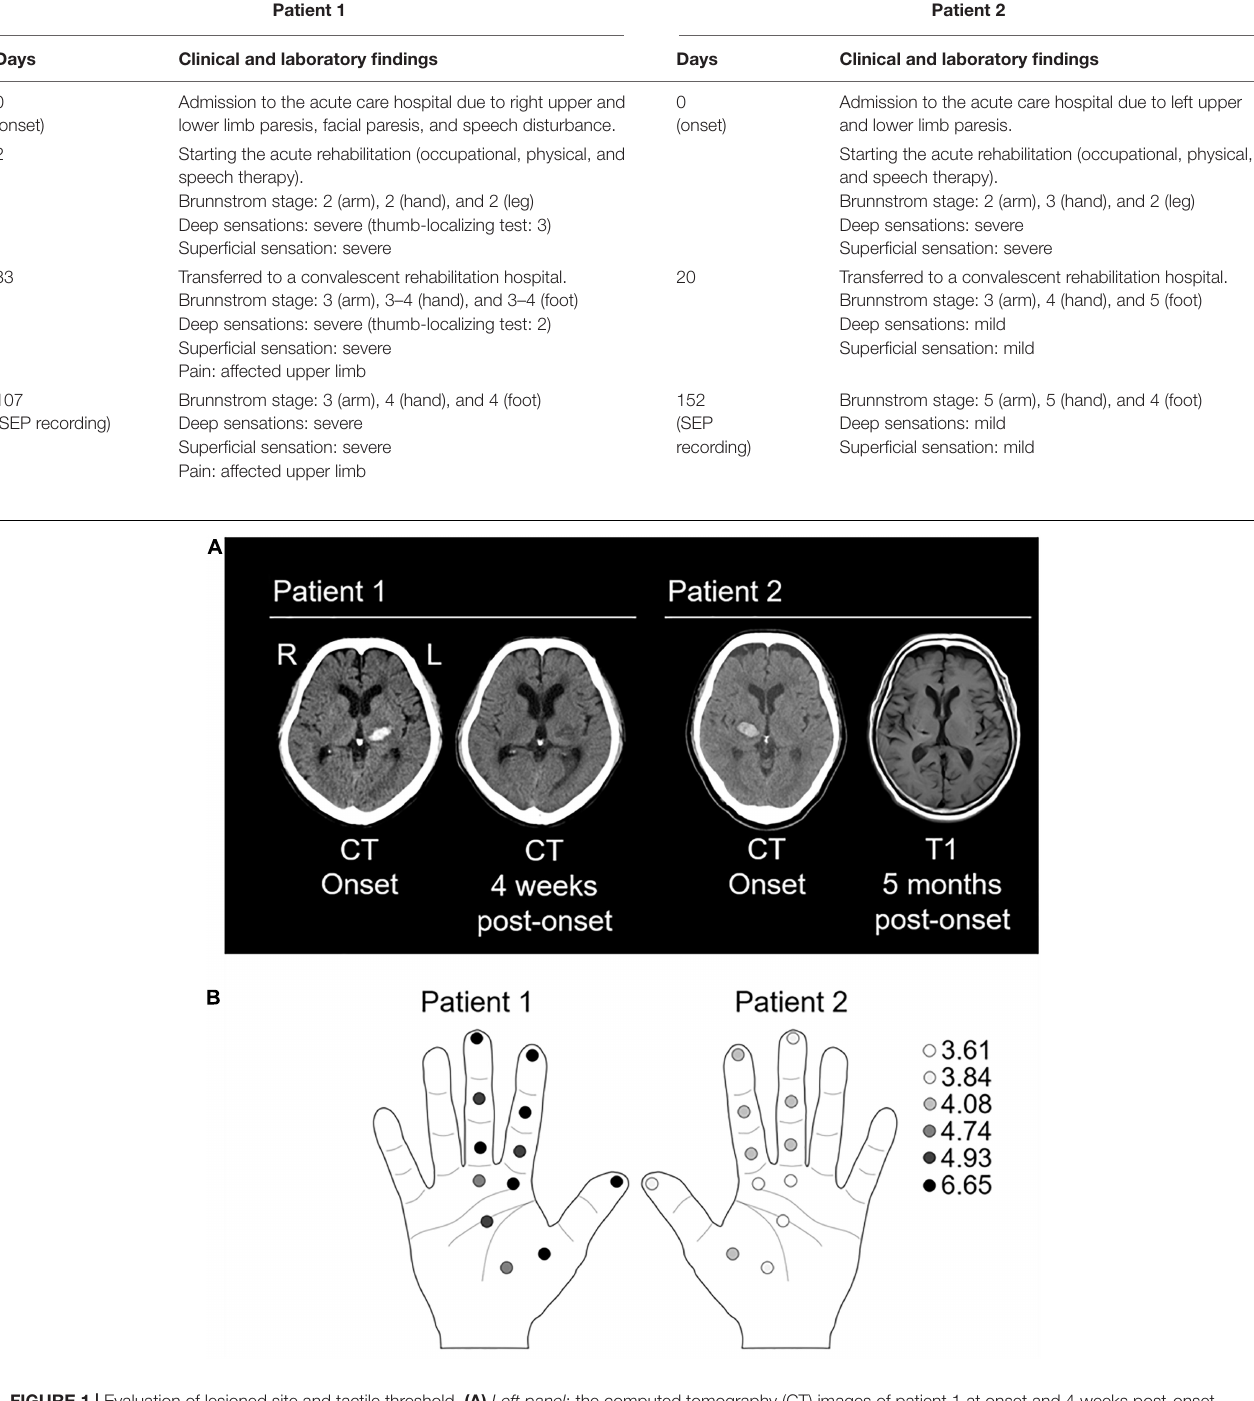
FIGURE 1 | Evaluation of lesioned site and tactile threshold. (A) Left panel : the computed tomography (CT) images of patient 1 at onset and 4 weeks post-onset show a high-and low-density area in the left thalamus, respectively. Right panel : the CT image at onset and T1-weighted magnetic resonance image at 5 weeks post-onset in patient 2 show a high-density area and a low signal-intensity area in the right thalamus, respectively. (B) Left panel showing tactile thresholds in patient 1. Right panel showing tactile thresholds in patient 2. The monofilaments of 20 different sizes (1.65–2.83, 3.22–3.61, 3.84–4.31, 4.54–6.45, and 6.65 expressed as the log of the bending force in mg) were applied to the index finger (three points), mother finger (one point), middle finger (three points), and palm (five points). Normal: 1.65–2.83; diminished light touch: 3.22–3.61; diminished protective sensation: 3.84–4.31; loss of protective sensation: 4.56–6.45; deep pressure sensation: 6.65; and unmeasurable: > 6.65 (Bell-Krotoski and Tomancik, 1987; Jerosch-Herold,